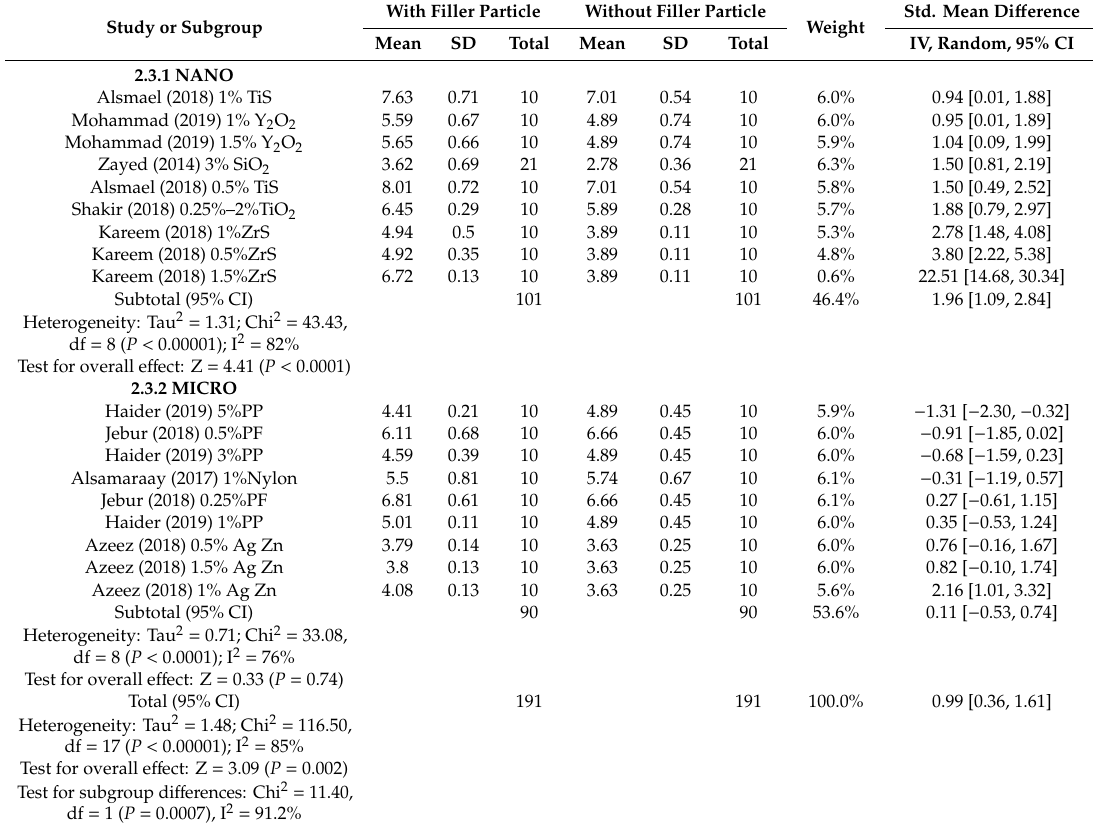
Table 4. Subgroup analysis and forest plot of tensile strength (MPa)